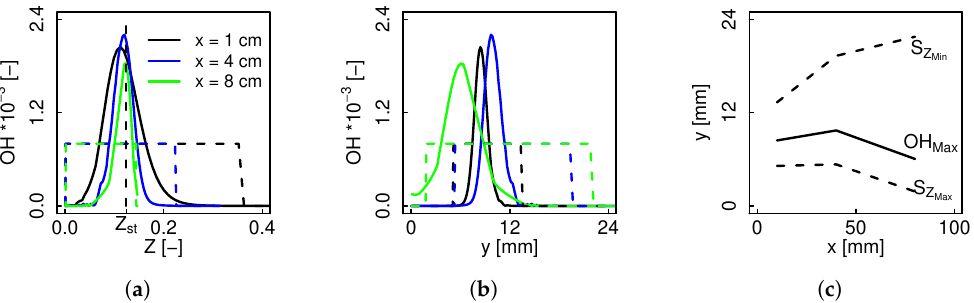
Figure 11. OH radial profiles for ∆ = 2 mm at different downstream locations represented in mixture fraction ( a ) and physical space ( b ). ( c ) corresponds to the limit values of ( b ) along the axial direction. Solid lines OH, dashed lines flame sensor.